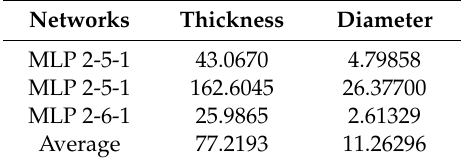
Table 3. Sensitivity analysis carried out using neural